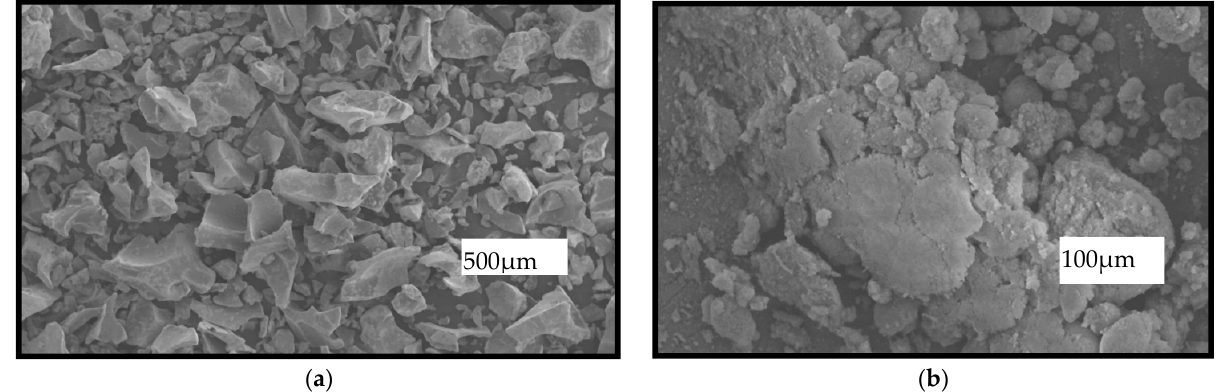
Figure 2. ( a ) SEM image of SAP particles; ( b ) SEM image of nano-silica.